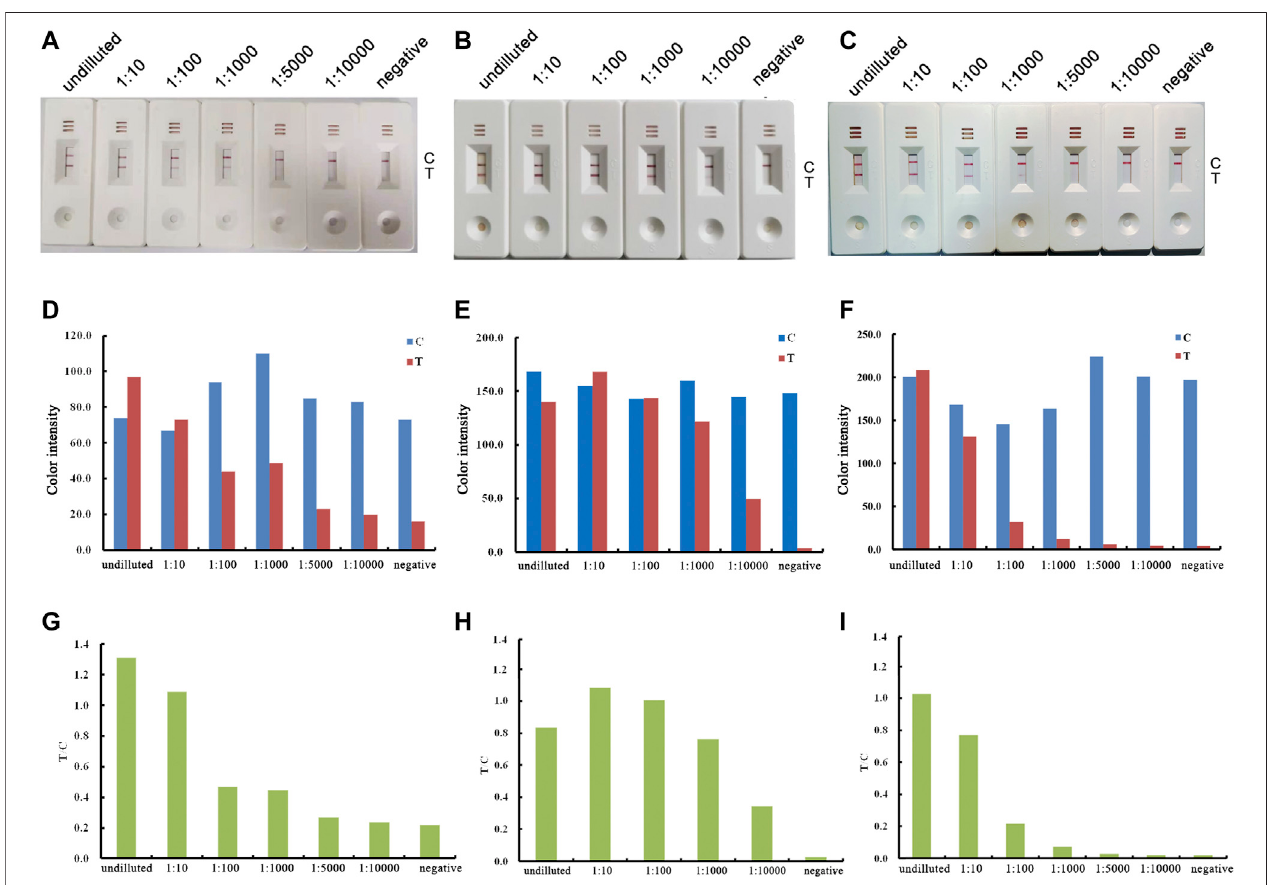
FIGURE 4 | Optimization of the labeled antigen and capture antigen. The results of using untreated p72 trimer as both labeled antigen and capture antigen are shownintheleftcolumn (A,D,G) ;theresultsofusingacid-treatedp72aslabeledantigen,untreatedp72trimerascaptureantigenareshowninthemiddlecolumn (B,E, H) ;theresultsofusingacid-treatedp72asbothlabeledantigenandcaptureantigenareshownintherightcolumn (C,F,I) .Realdetection fi guresofsensitivityanalysisof ASFV antibody by lateral fl ow assay (A, B, C) . The color intensity values of the test line (T value) and control line (C value) of the lateral fl ow assay (D, E, F). The T/C value of lateral fl ow assay (G, H, I)